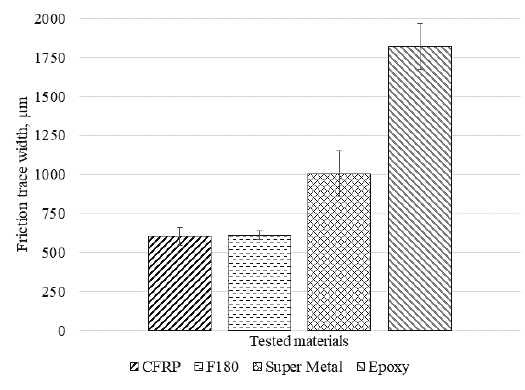
Figure 12. Friction trace width